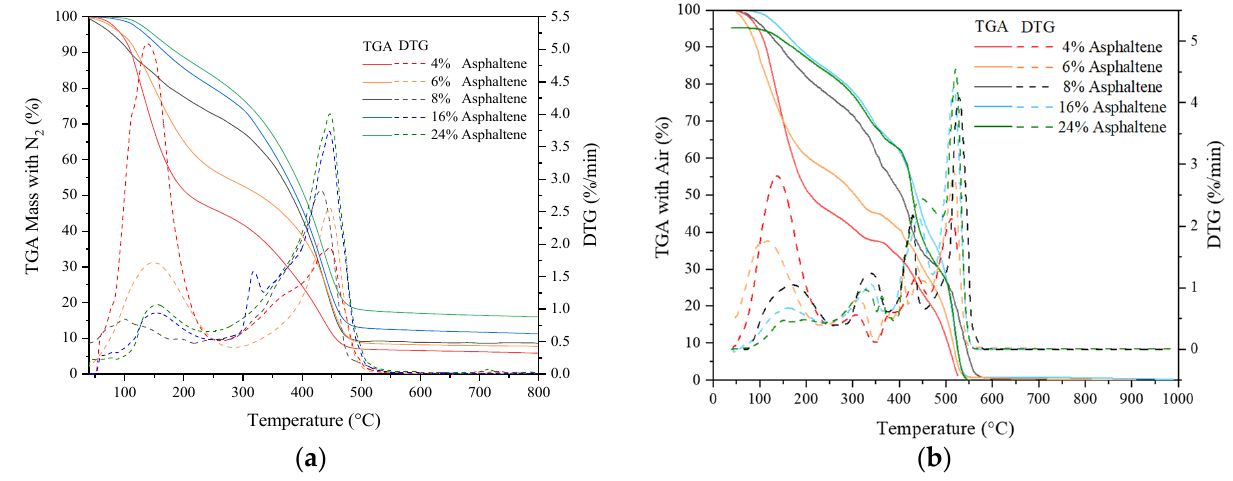
Figure 4. TGA and DTG distribution of HFO with different asphaltene contents. ( a ) N 2 atmosphere. ( b ) Air atmosphere.